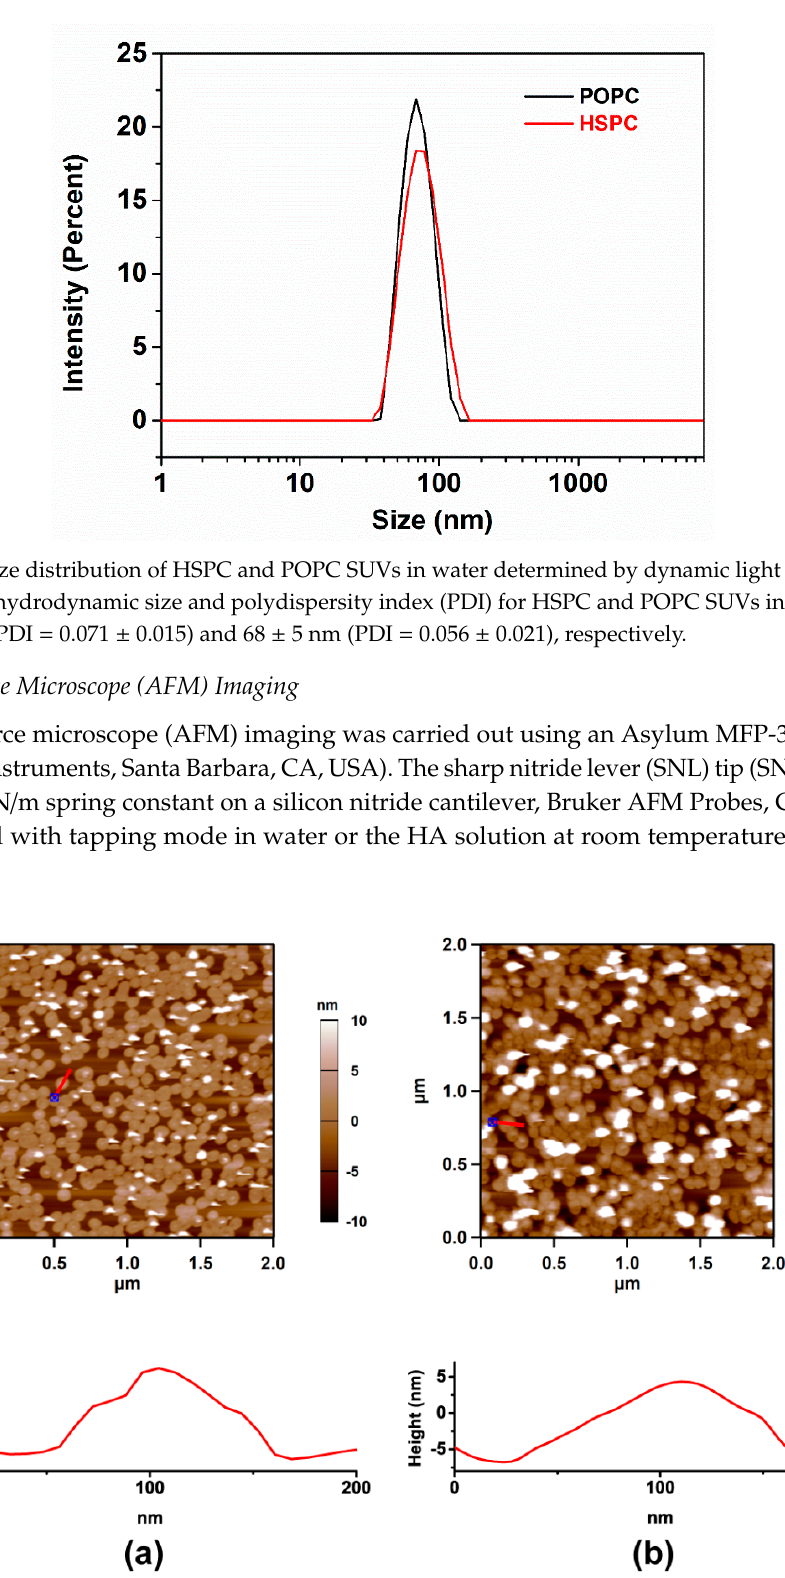
Figure 3. Atomic force microscope (AFM) images of HSPC SUVs adsorbed on mica under water ( a ) and HA solution ( b ). The height distance cross section of the surface along the red line is presented below each image.